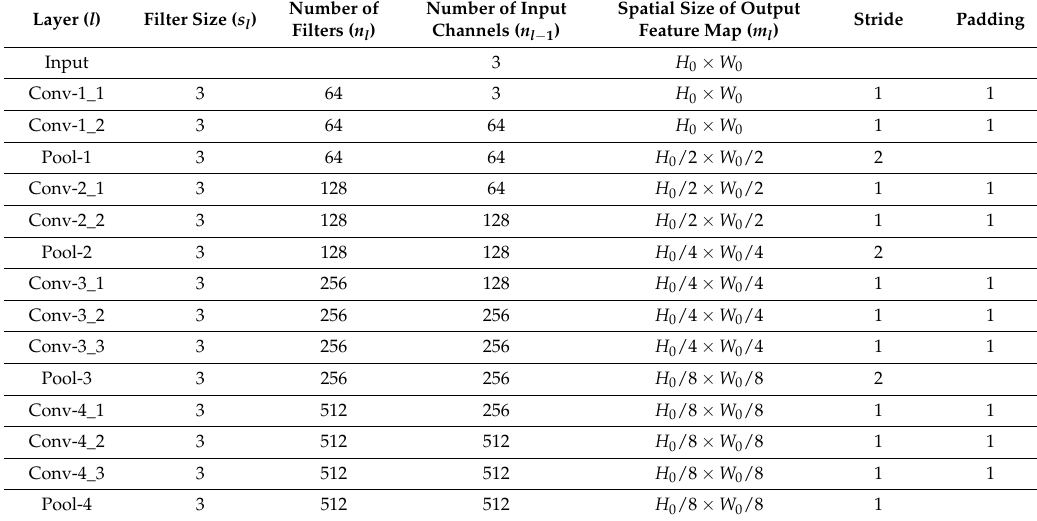
Table 6. Convolutional Layer Parameters of